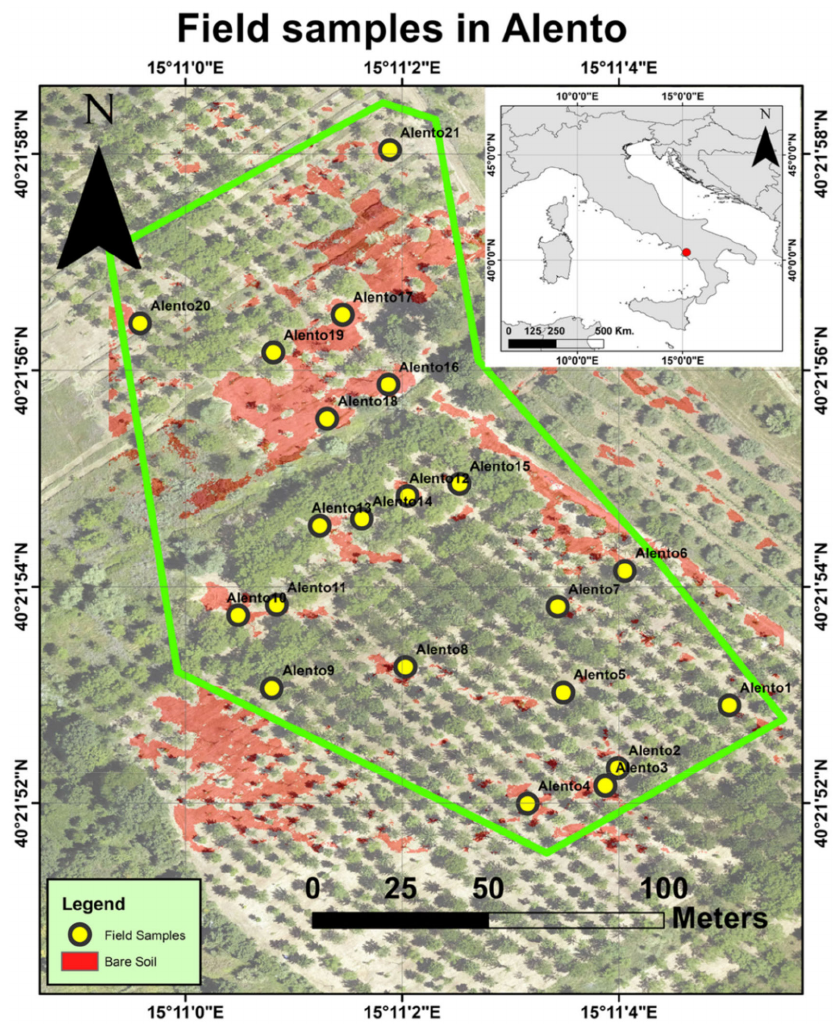
Figure 3. RGB image of the study area with the sample collection